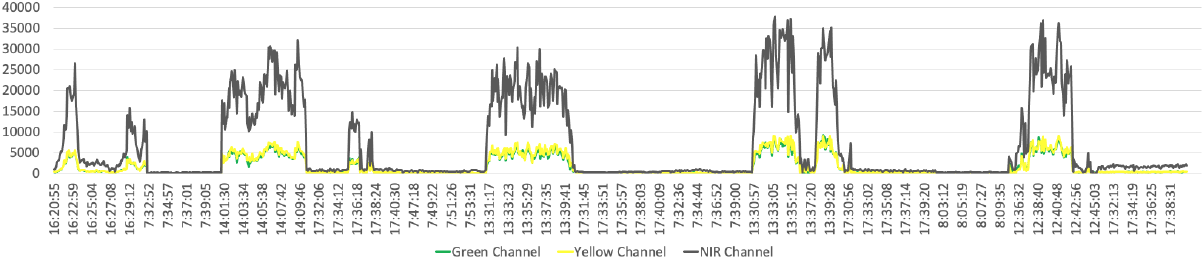
Figure 12. Aerial green, yellow, and NIR channel data distance from corresponding ground-based channel